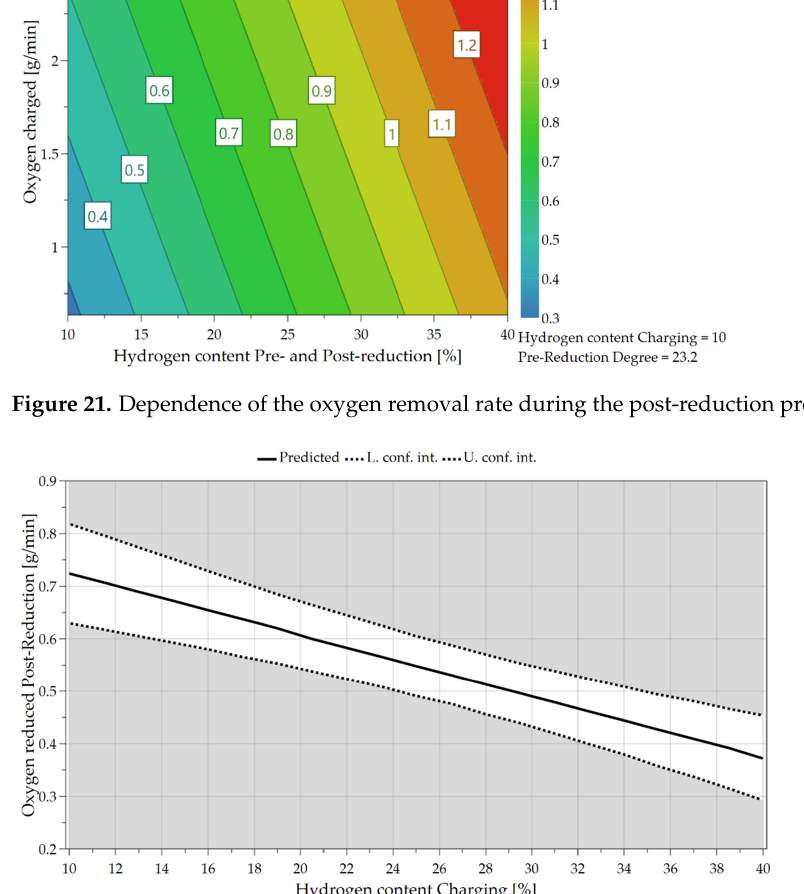
Figure 24. Oxygen removal rate in the post ‐ reduction depending on the introduced oxygen through iron ore charging. 4.4. Reaction Rate Constant for Hydrogen Reduction The reduction rate r describes the oxygen removal rate for the reduction of liquid iron oxide melt with hydrogen related to the reaction area in the plasma focal hot spot [15].